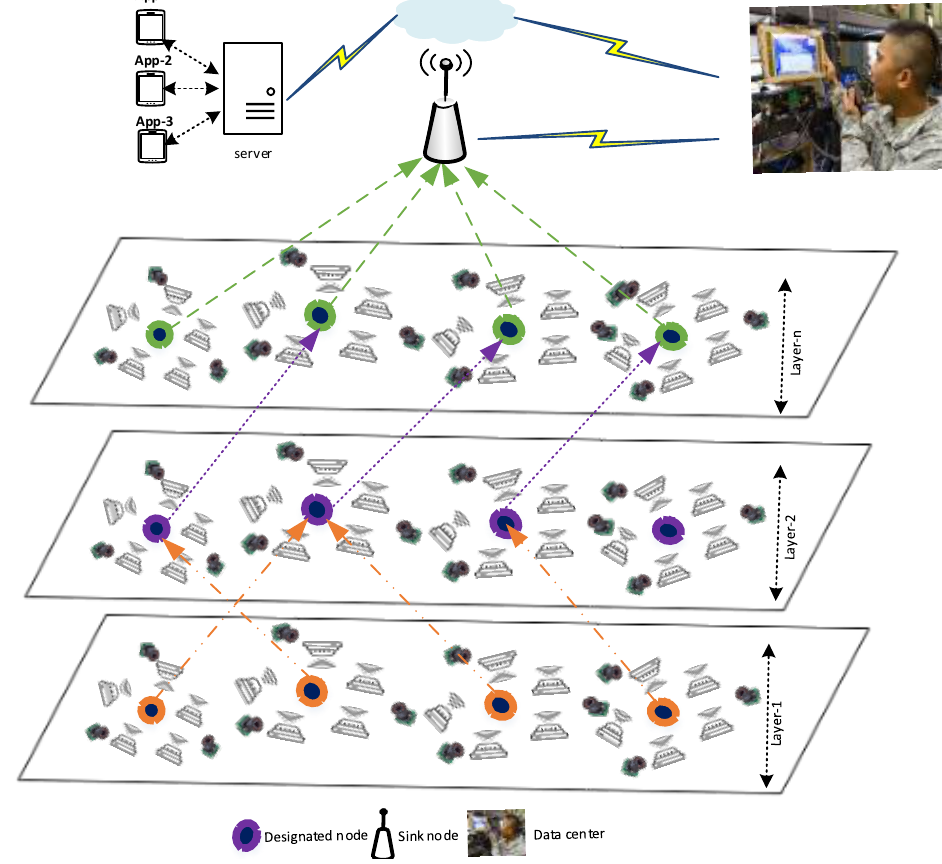
Figure 2. CIDF-WSN system